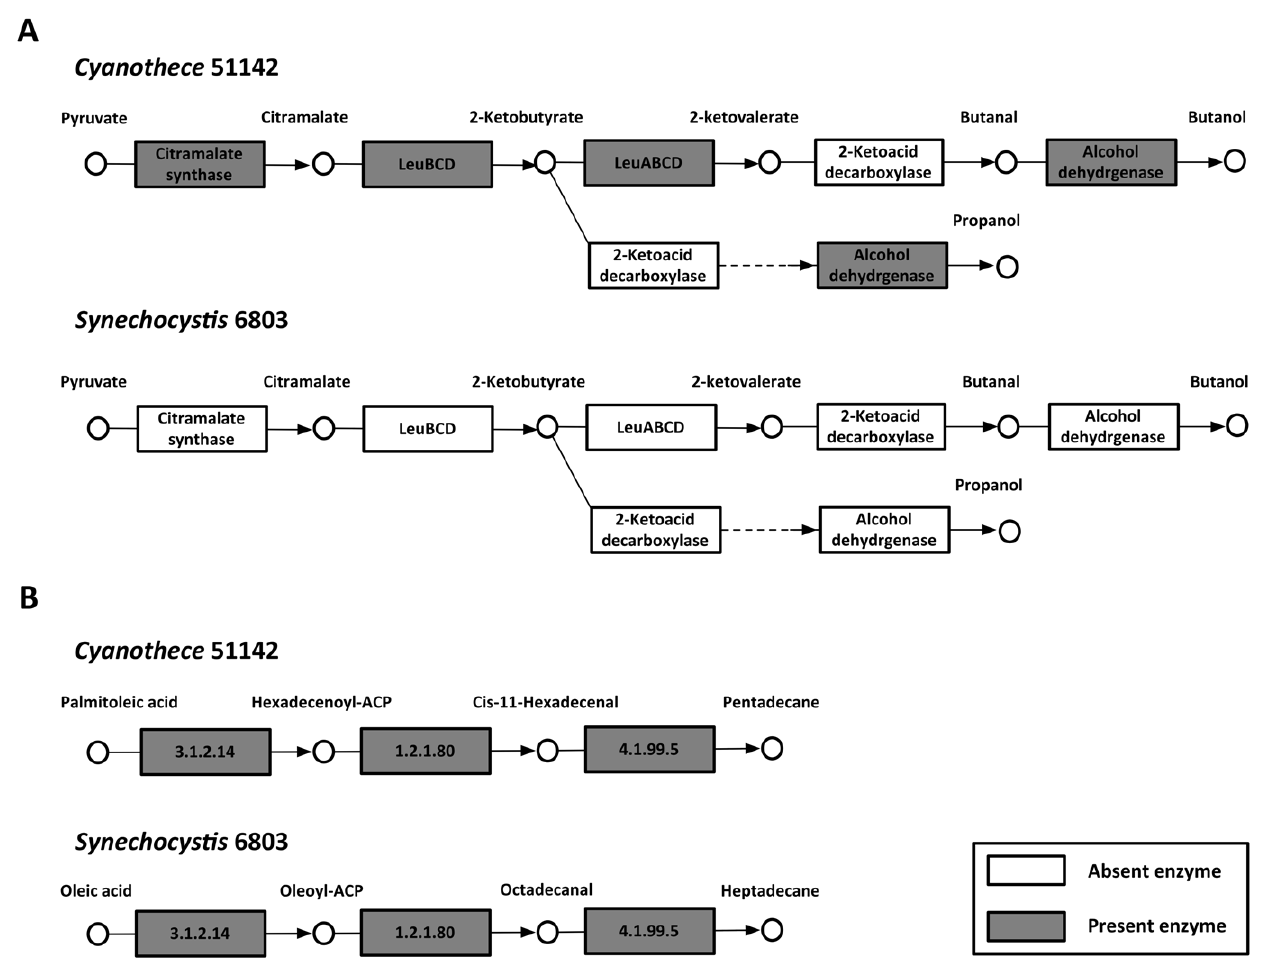
Figure 6. Examples of pathways that differ between the two cyanobacteria. (A) Nonfermentative alcohol production pathway highlighting the present and absent enzymes in Cyanothece 51142 and Synechocystis 6803, and (B) Alkane biosynthesis pathways in Cyanothece 51142 and Synechocystis 6803.